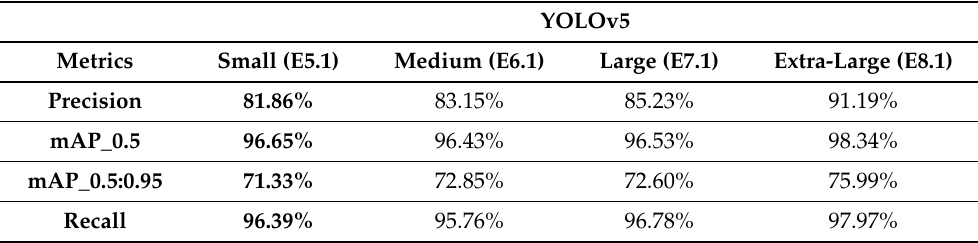
Table 11. Metrics obtained from trials in Table 10. Bold lines represent results for selected model.